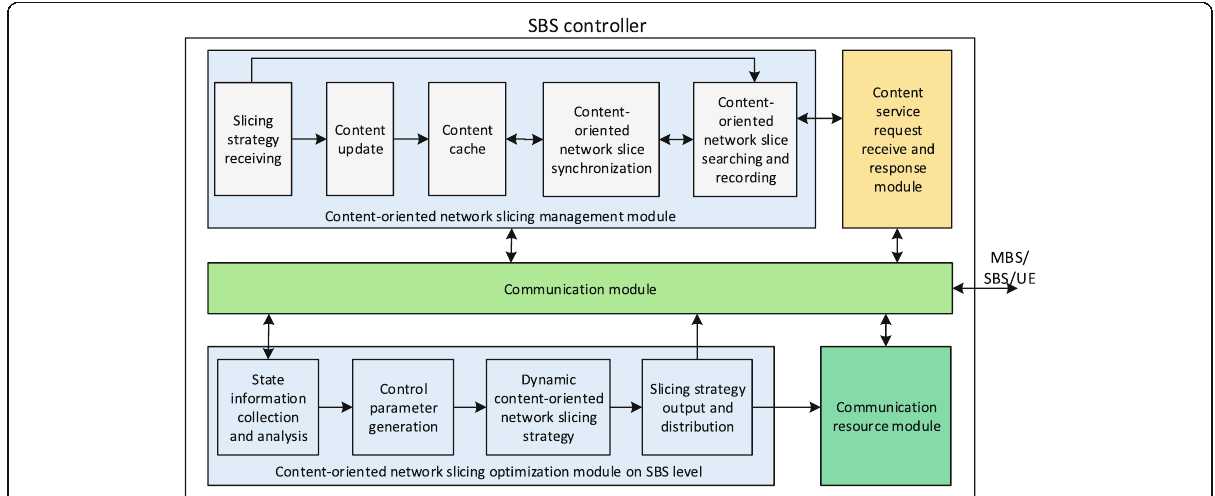
Fig. 5 The functional modules in a SBS